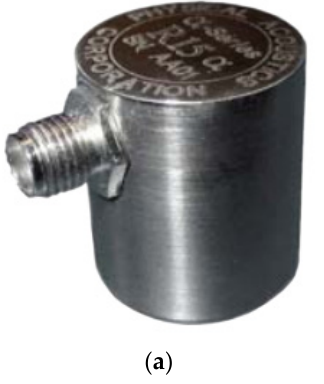
The physical picture of the sound source PZT and the optical fiber ultrasonic sensor are